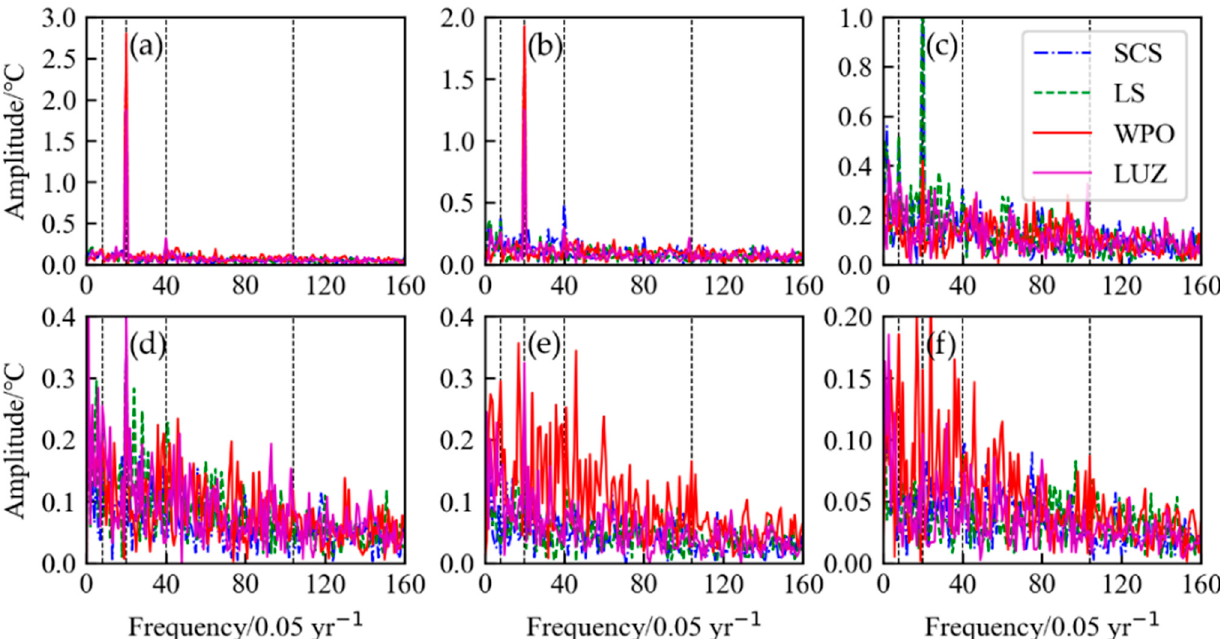
Figure 3. Potential temperature frequency spectrum of four subregions at different depths (see Figure 1. for the location of subregions and sampling points). The black dotted lines (from left to right) in each subgraph indicate periods of 2.5, 1, 0.5, and 0.2 year, respectively. ( a ) 25 m; ( b ) 56 m; ( c ) 110 m; ( d ) 222 m; ( e ) 454 m; ( f ) 644 m.